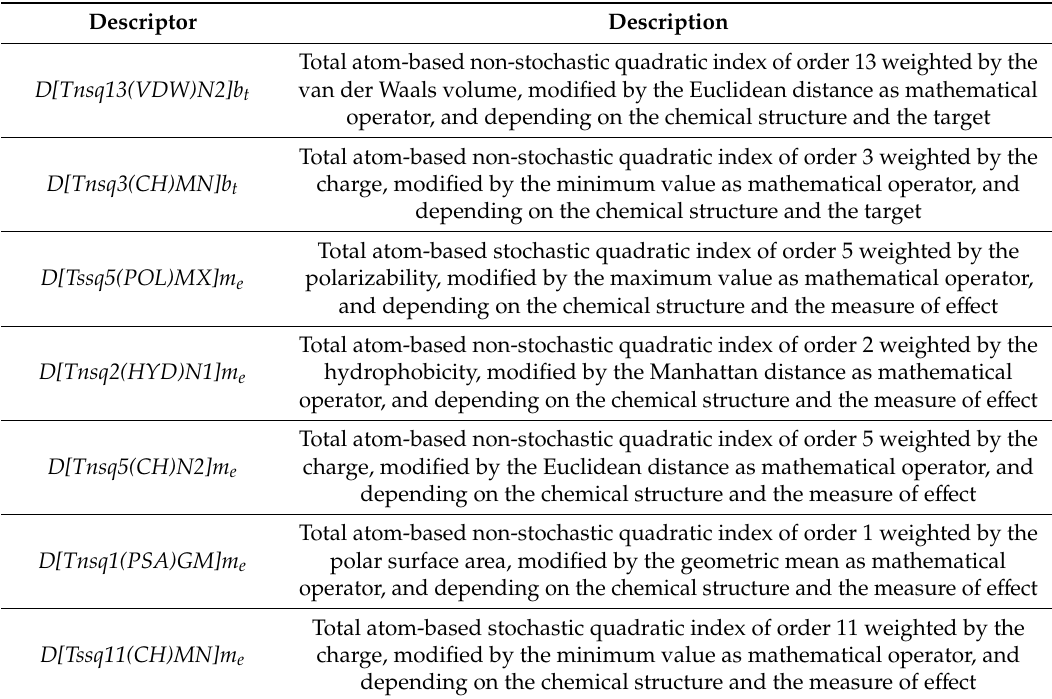
Table 3. Molecular descriptors of the mt-QSAR-LDA model and their respective definitions. Descriptor